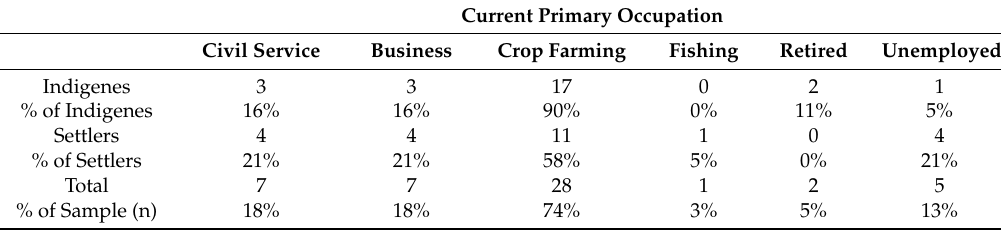
Table 4. Occupations of the affected persons after the resettlement (number of indigenes = 19; number of settlers = 19).